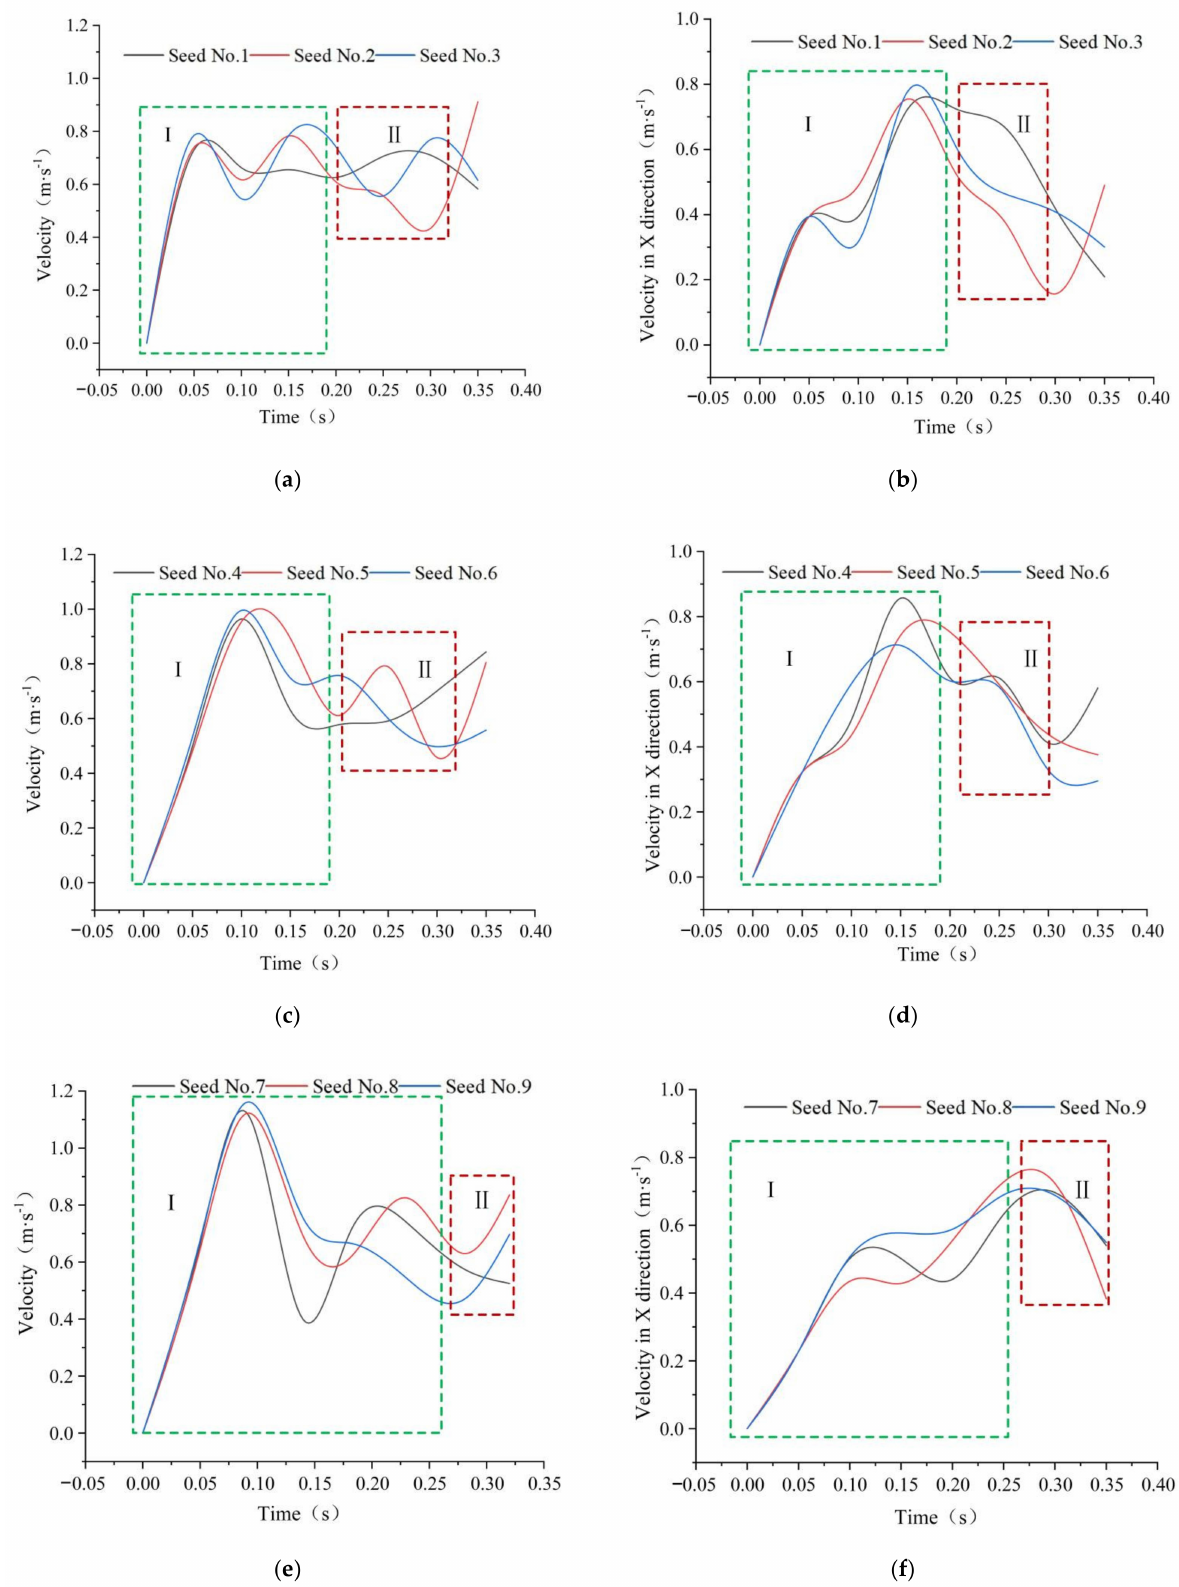
Figure 8. The seed-velocity profile ( a ) 30 ◦ ;( c ) 45 ◦ ;( e ) 60 ◦ ; The velocity profile in the X -axis direction of the seeds ( b ) 30 ◦ ;( d ) 45 ◦ ;( f ) 60 ◦